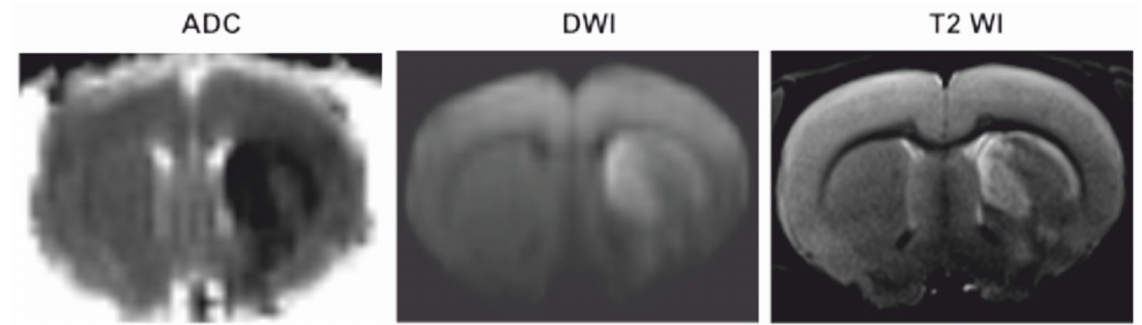
Figure 1. MRI of ischemic foci after tMCAO. DWI with an ADC map and T2 WI scans of the formation of ischemic injury areas with a subcortical localization in the brain of rats at 24 h after